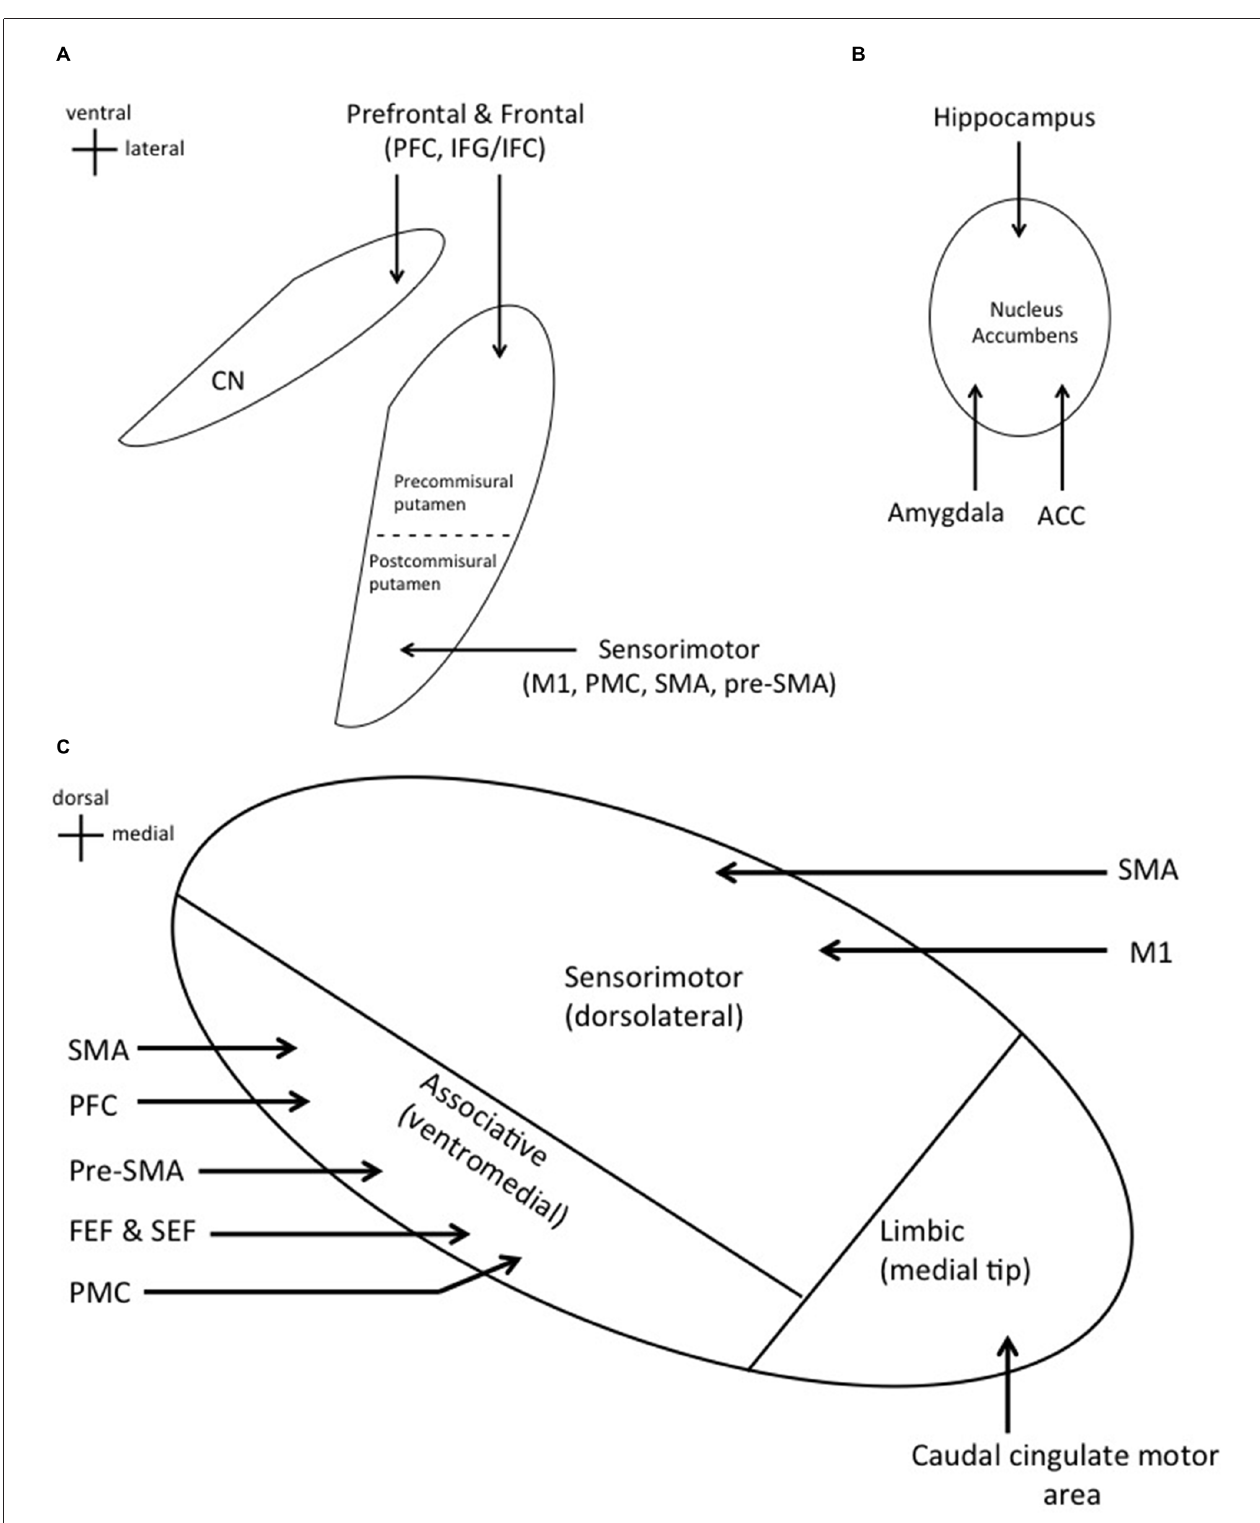
FIGURE 1 | (A) Cortical inputs into specific regions of the dorsal striatum. Prefrontal and frontal cortical areas project to the caudate nucleus (CN) and precommisural putamen. Sensorimotor cortices project to the postcommisural putamen. (B) Projections from the hippocampus, amygdala, and anterior cingulate cortex (ACC) to the nucleus accumbens (NA; ventral striatum). (C) Cortical inputs into specific regions of the subthalamic nucleus (STN). Significant overlap is seen with these two input structures as expected.